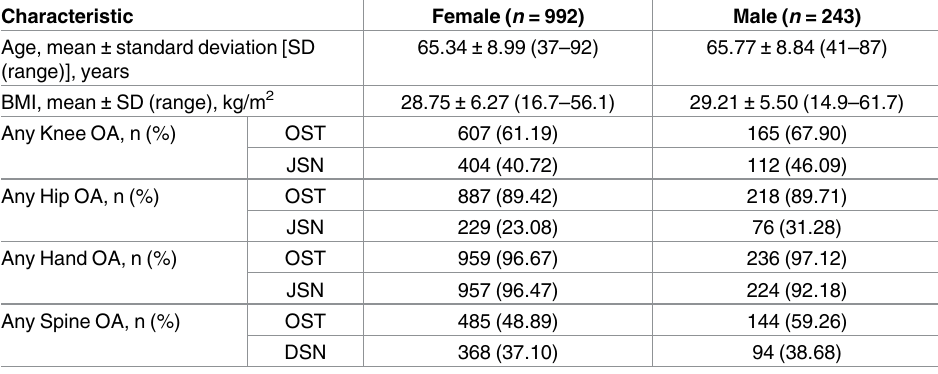
Table 1. Demographic characteristic of the 1235